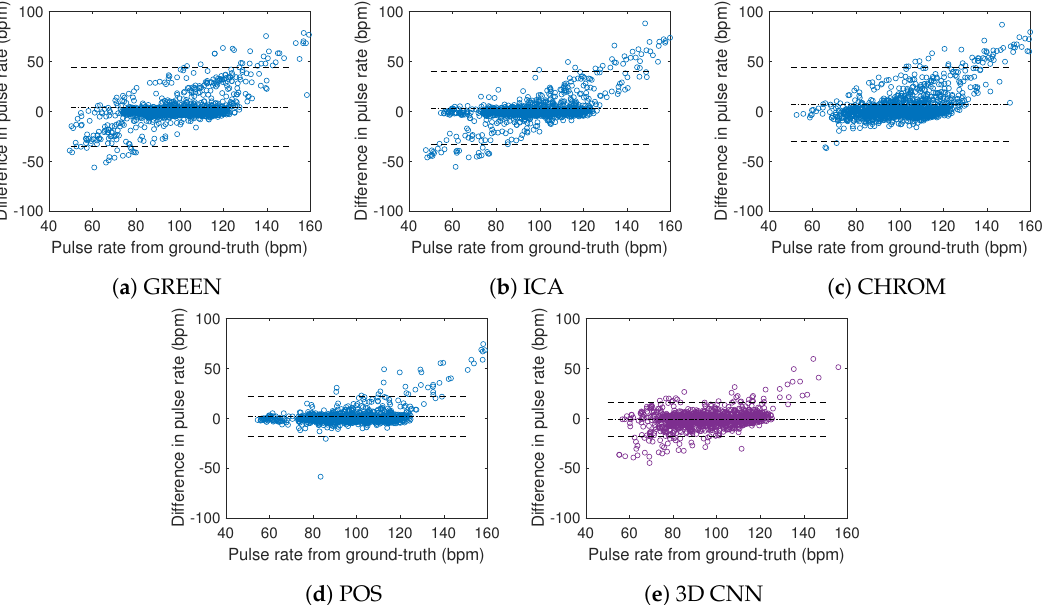
Figure 10. Beat-to-beat Bland–Altman plots showing the differences in pulse rate between video and ground-truth measurements, plotted against ground-truth measurements. Means are represented by dash-dot lines and 95% limits of agreement ( ± 1.96 SD) by dashed